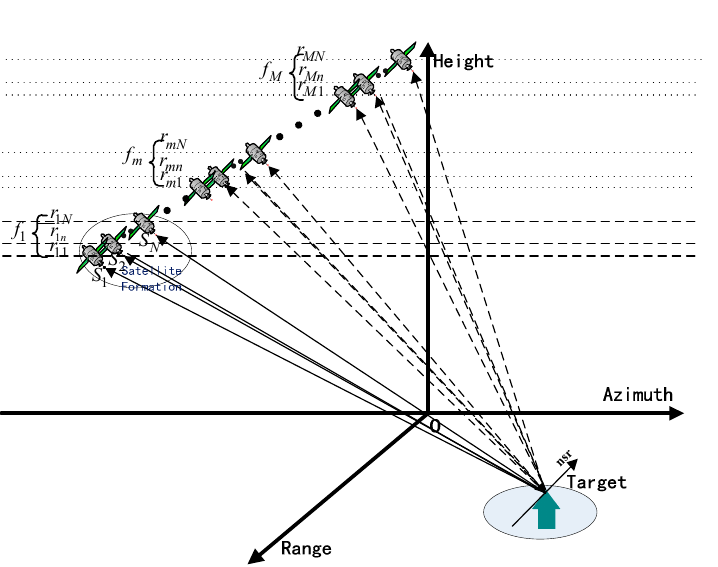
Figure 1. Spatial geometry model of a spaceborne multistatic synthetic aperture radar tomography (SMS-TomoSAR) system (normal-slant-range (nsr) direction).